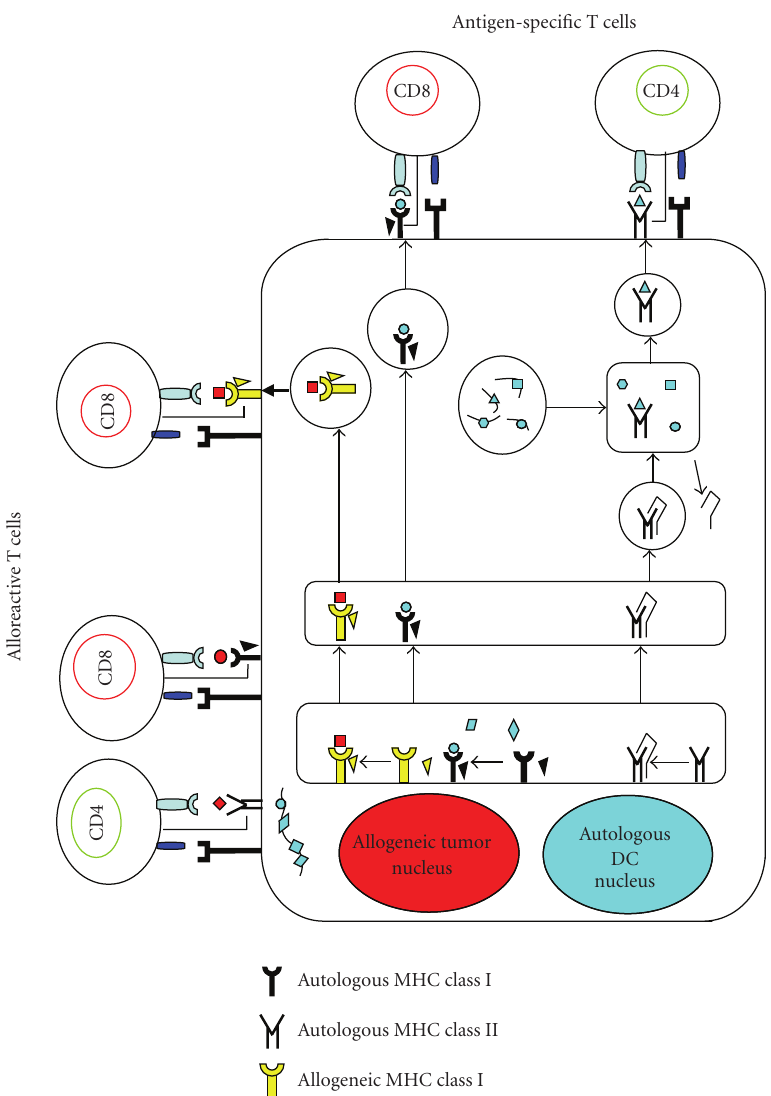
Figure 2: Fusions of autologous DCs and allogeneic tumor cells (DCs/allo-tumor). The DCs/allo-tumor can stimulate both CD4+ and CD8+ T cells as same as fusions of autologous DCs and autologous DCs (DCs/auto-tumor). Moreover, the DCs/allo-tumor can also stimulate alloreactive T cells due to the presence of allogeneic HLA class I molecules from allogeneic tumor cells. Autologous MHC molecules present foreign peptide derived from allogeneic tumor cells to T cell selected to recognize self MHC-foreign peptide complexes. In addition, T cell also can recognize an allogeneic MHC molecule whose structure resembles the self MHC-foreign peptide complexes and structure formed by both the allogeneic MHC molecules and the bound